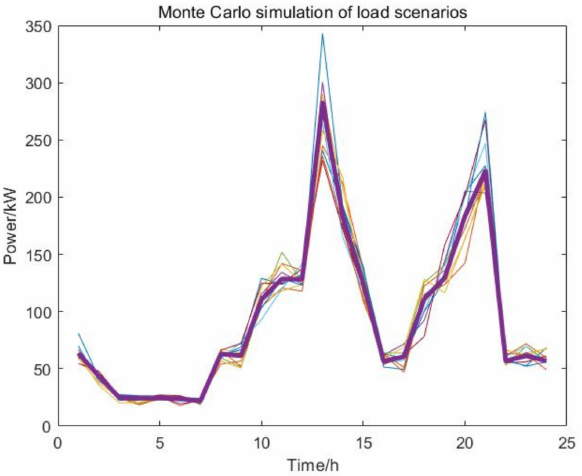
Figure A3. Typical load power